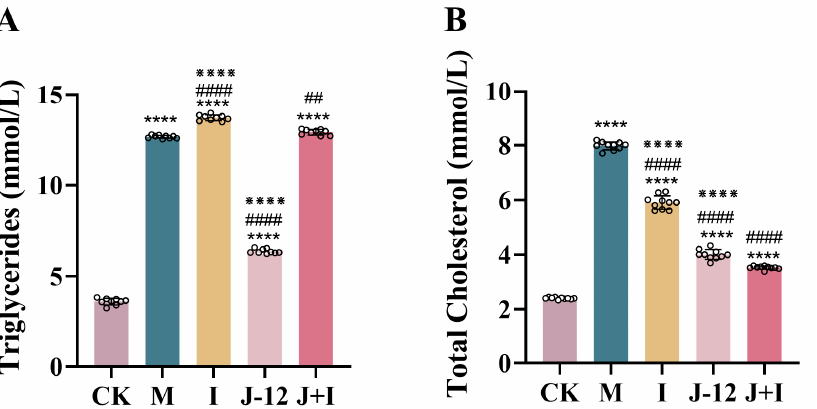
Figure 2. J-12 improved dyslipidemia in rats with hyperglycemia in pregnancy. ( A ) Triglycerides. ( B ) Total cholesterol. CK: control group, rats fed a standard diet. M: model group, rats fed an HFD